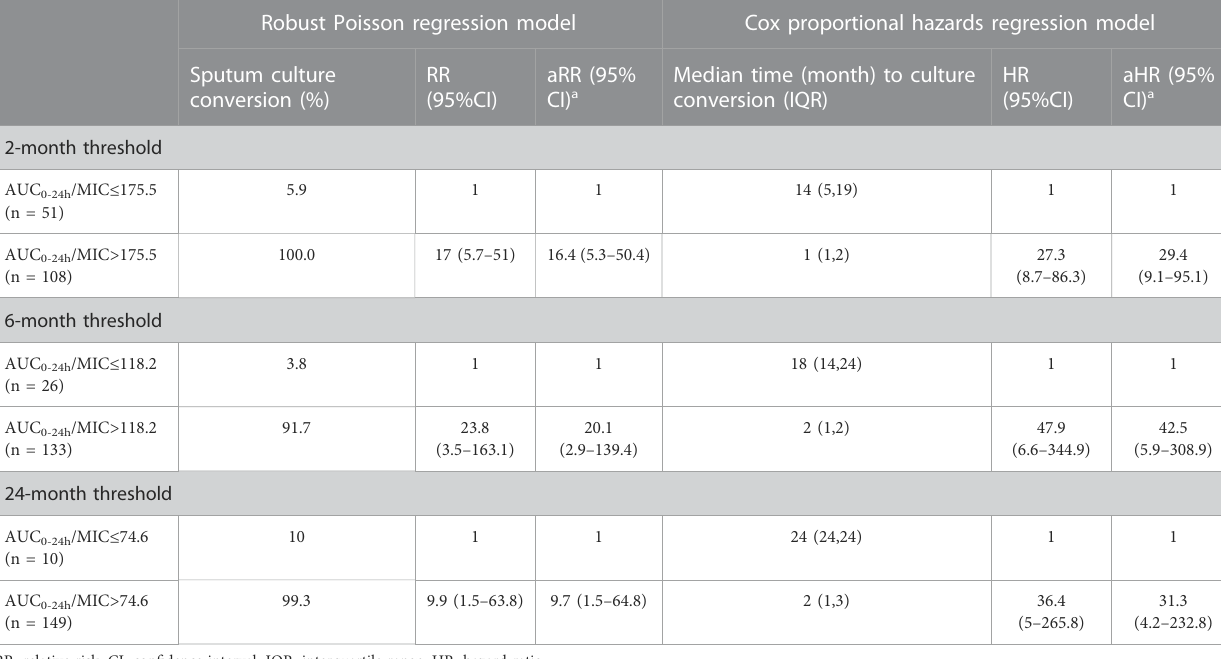
TABLE 4 Association between the thresholds and sputum culture conversion among the participants in the validation cohort. Robust Poisson regression model Cox proportional hazards regression